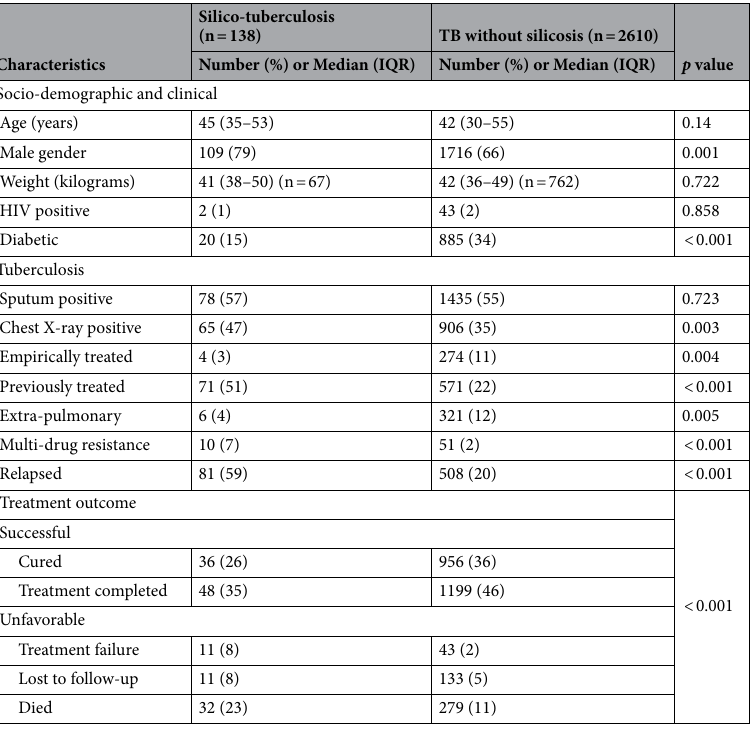
Table 1. Differences in characteristics of patients with silico-tuberculosis and TB patients without silicosis in Khambhat block. IQR: Interquartile Range; HIV: Human Immunodeficiency Virus; TB: Tuberculosis.